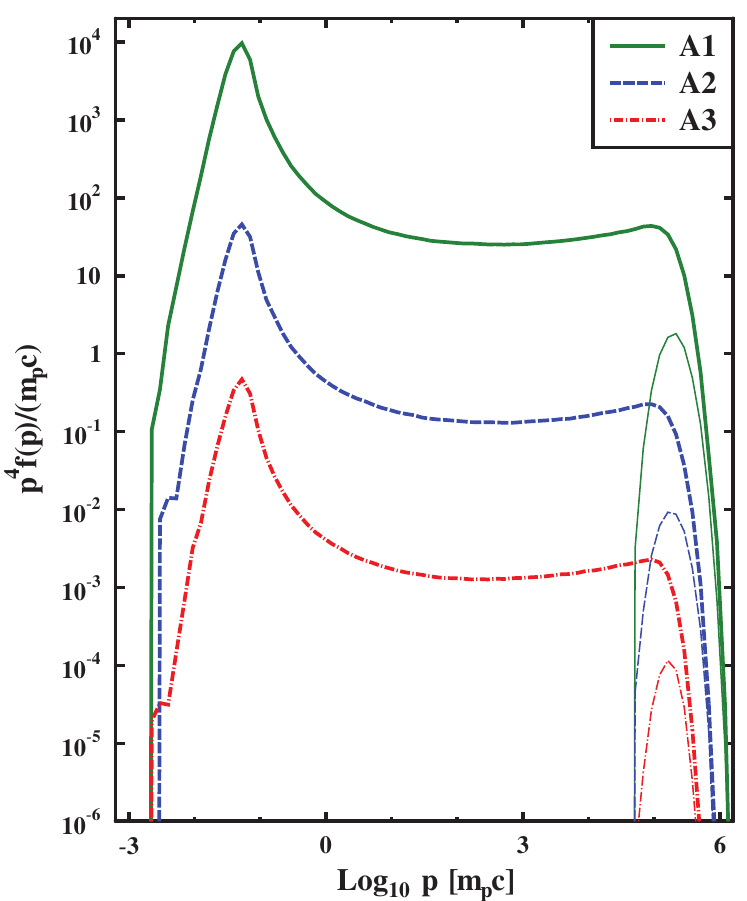
Figure 8. The particle distribution function in the shock rest frame, the thick curves correspond to the point x = 0 (the front shock), the thin curves correspond to the point x = x FEB . The correspondence to Table 1 is reflected in the